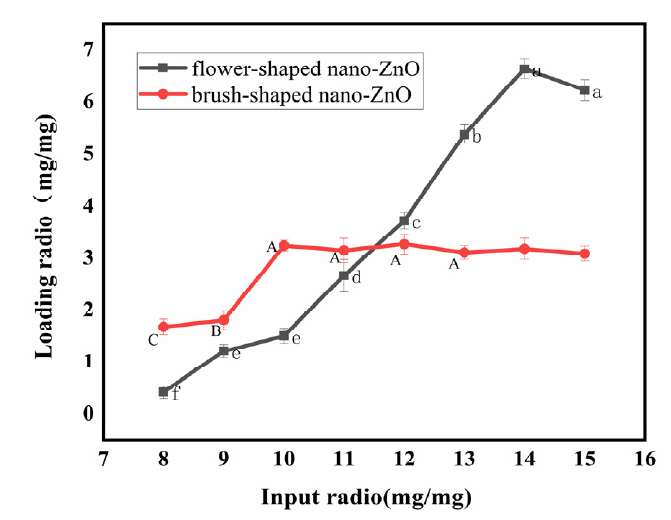
Figure 2. The loading capacity of TeA monoclonal antibodies on nano-ZnO with different morphology.